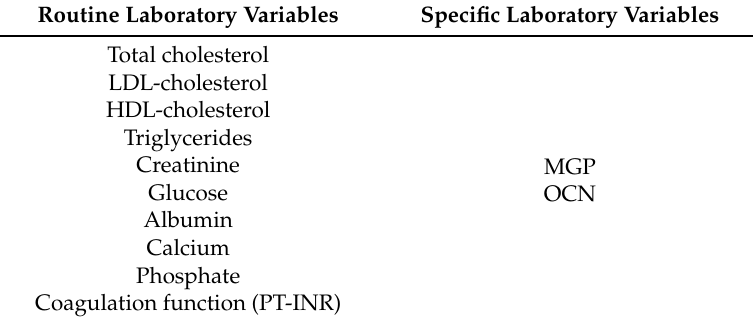
Table 3. Laboratory assessment.